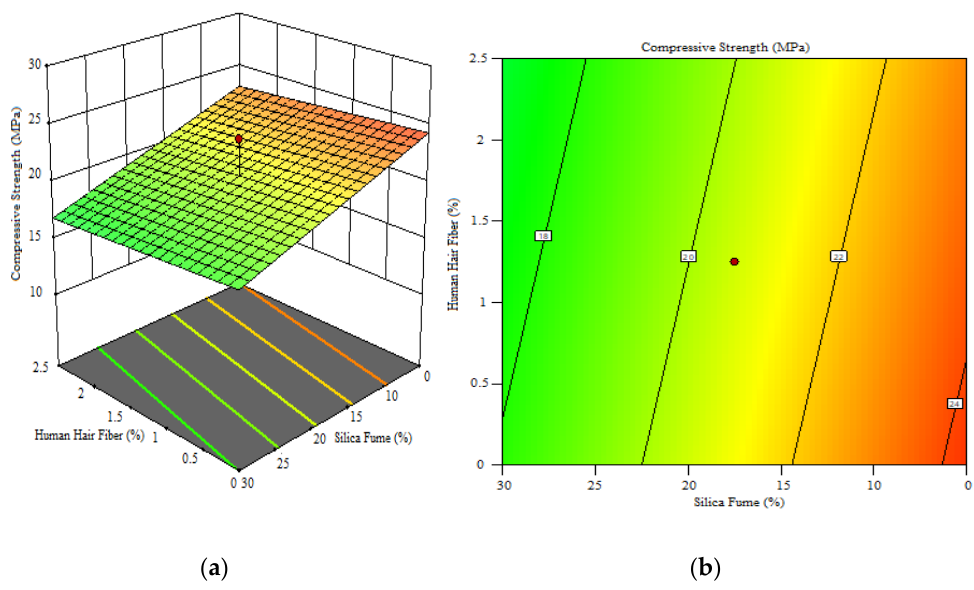
Figure 3. ( a ) 3D surface diagram for compressive strength; ( b ) 2D contour for compressive strength.